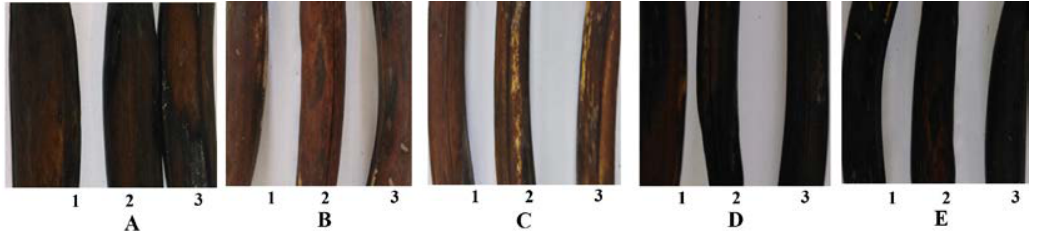
Fig. 3.6. 21 st day of banana sample treated with different treatment (before peeling) A. Sodium alginate B. Starch